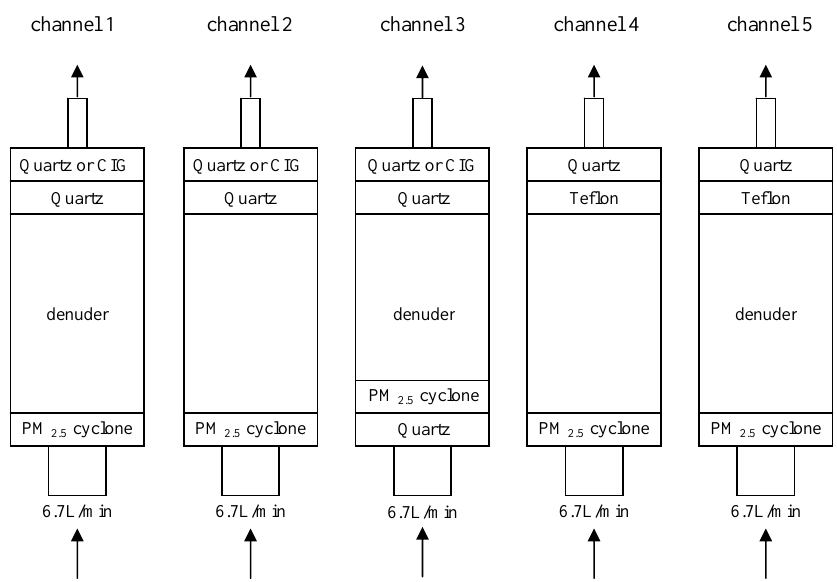
Figure 2. Configuration of the SASS sampler. In the winter of 2009, all the five channels were operated; in the summer, channel 3 was not included during the sampling period, instead was run for 6 days after the sampling was finished; in the spring, only channel 1–3 were operated. The backup filter used in channel 1–3 was quartz in winter and summer, and was CIG in spring. See text for the purpose of different designs.